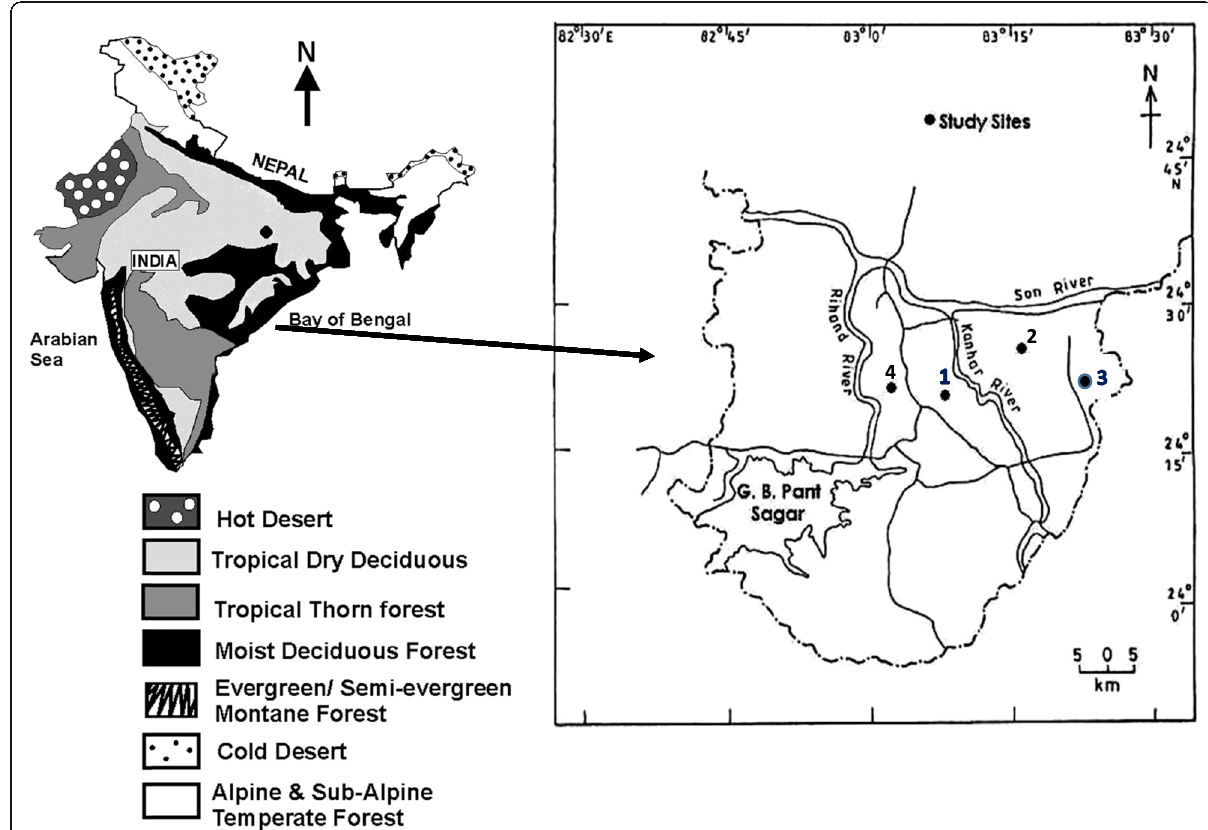
Fig. 1 Location of the study sites. Numbers 1, 2, 3, and 4, respectively, indicate approximate location of Hathinala, Gaighat, Harnakachar, and Ranitali sites. Figure for India includes major